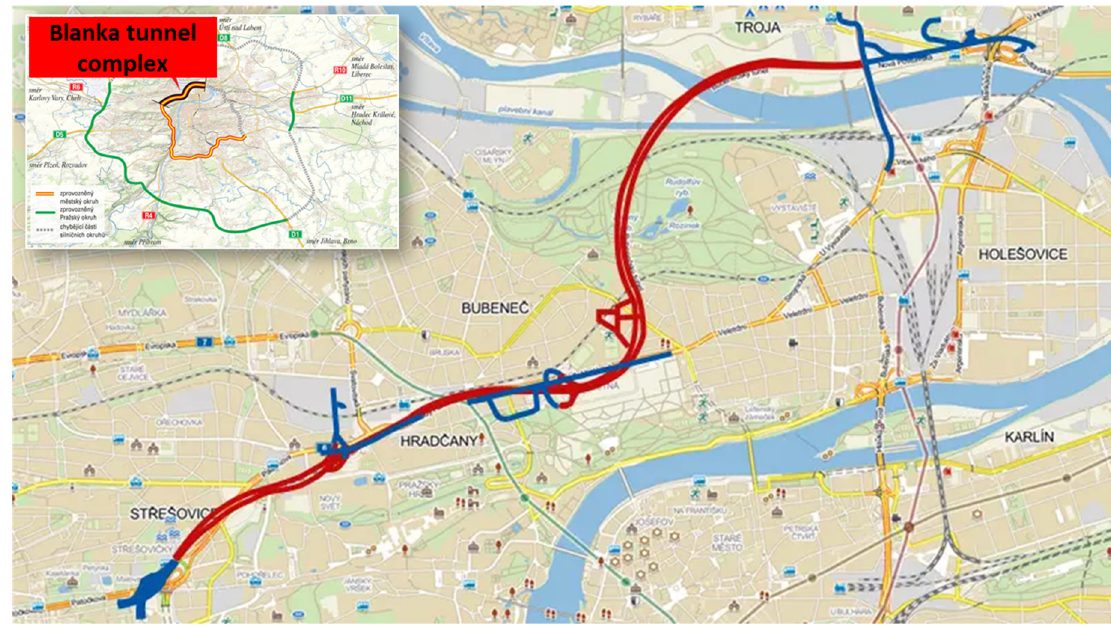
Figure 7. Schematic overview of the tunnel complex Blanka.